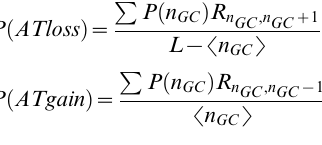
Figure S2 Heterogeneous trinucleotides distribution over low and high nucleosome occupancy sequences. A-B) Shown are log ratios of trinucleotide frequencies in low and high occupancy sequences (Y axis) against trinucleotide frequencies in high occu- pancy sequences (X axis) over TSS proximal sequences (A) and TSS distal sequences (B). Each trinucleotide is depicted by three adjacent color coded squares. Pairs of reverse complimented trinucleotides are averaged and depicted together. In addition to the clear preference of A/T trinucleotides for low occupancy sequences (notice the abundant AAA), we note the differences in G/C trinculeotide preferences between the occupancy groups. (C,D) shown are the log ratios of trinucleotide frequencies (same as A,B) over TSS proximal sequences (C) and TSS distal sequences (D).